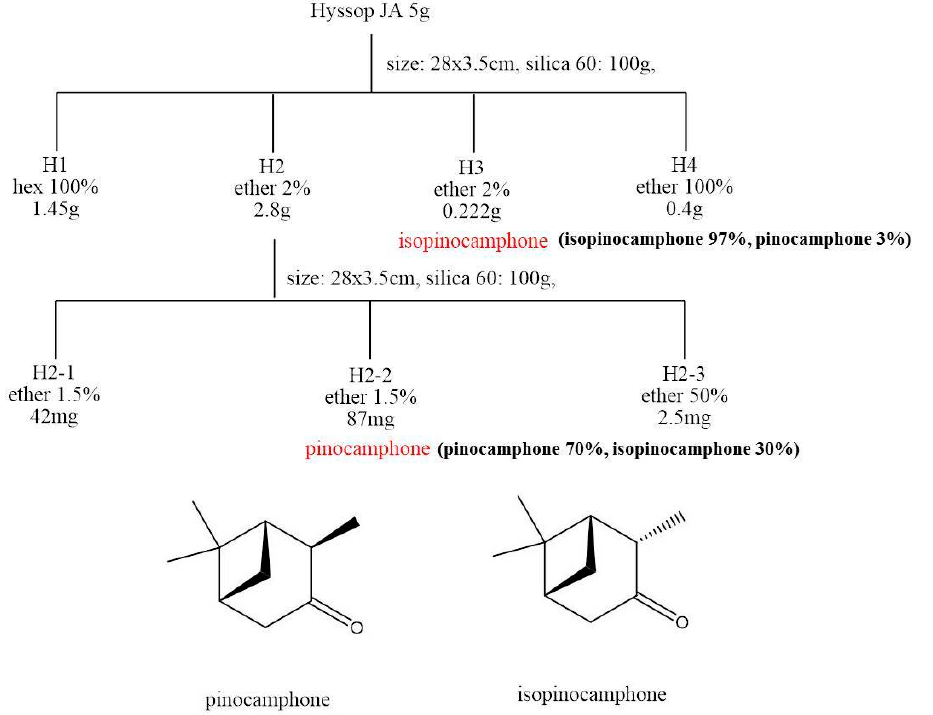
Figure 2. Isolation procedure of isopinocamphone and pinocamphone, and their chemical structures.